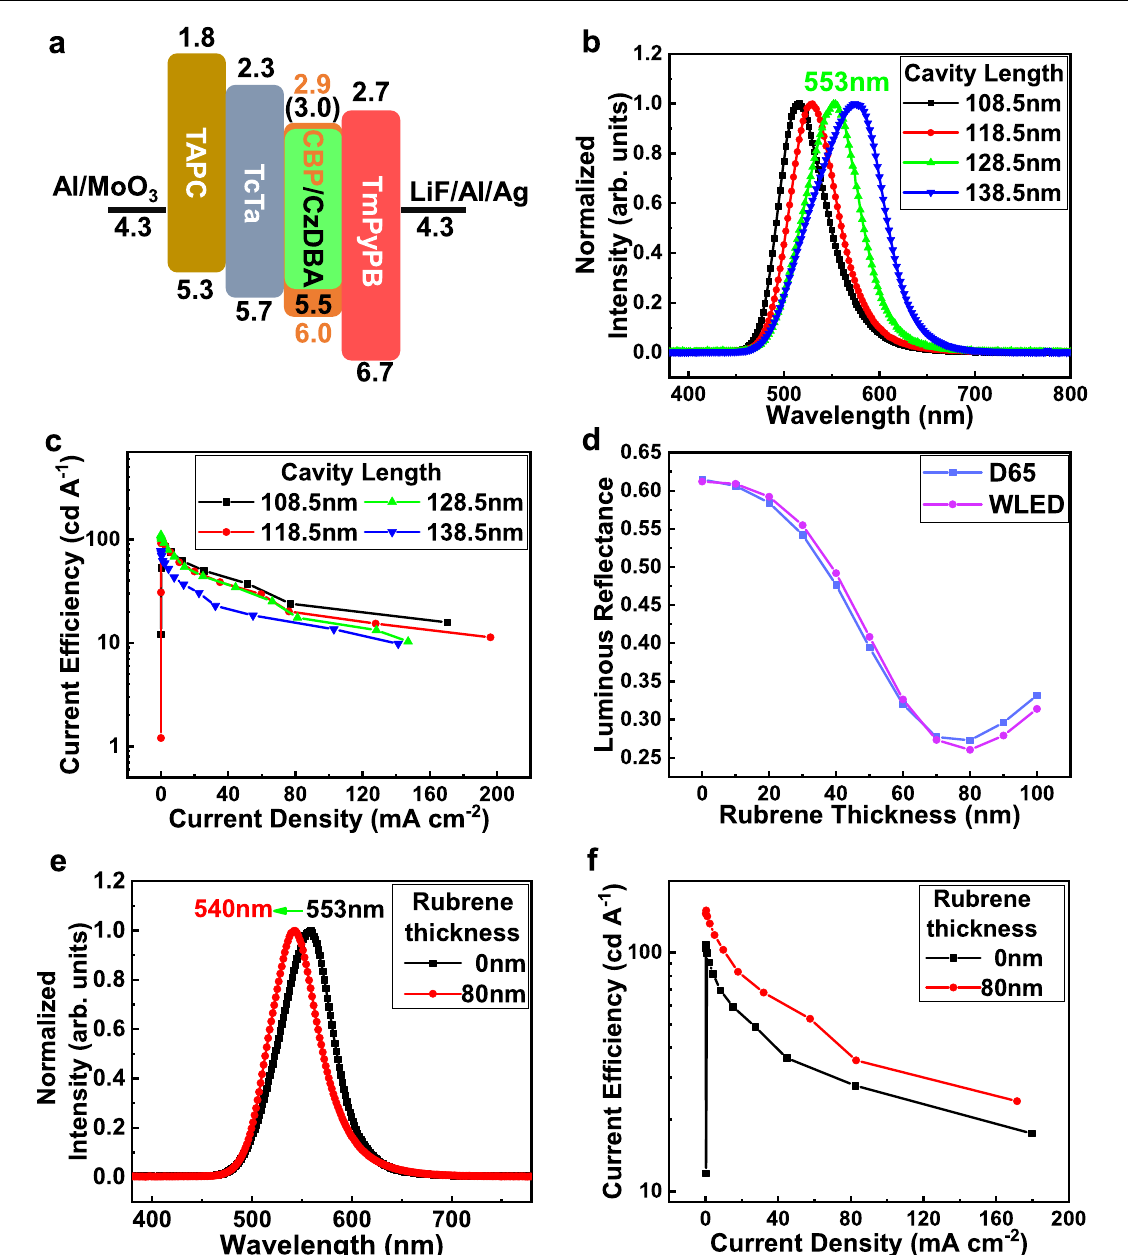
rubrene.Theblueandvioletsymbol-linesreferstotheconditionsofD65(sunlight) and WLED (indoor lighting) ambient light sources, respectively. e Normalized EL spectraand f currentef fi ciency-current density curves of TEOLEDs with orwithout rubrene. Source data are provided in a Source Data fi